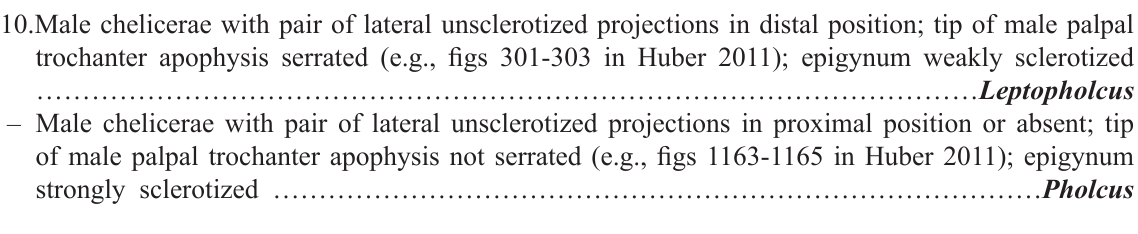
– Abdomen cylindrical or worm-shaped (Figs 2, 4) ………………………………………………10 9. Procursus with long hinged dorsal process, epigynum weakly sclerotized, internal u-shaped structure visible through cuticle frontally (figs 83-89 in Huber 2011) … Micropholcus fauroti (Simon, 1887) – Procursus widely curved, without long dorsal process (figs 204-205 in Huber 2003b); female unknown 10.Male chelicerae with pair of lateral unsclerotized projections in distal position; tip of male palpal trochanter apophysis serrated (e.g., figs 301-303 in Huber 2011); epigynum weakly sclerotized – Male chelicerae with pair of lateral unsclerotized projections in proximal position or absent; tip of male palpal trochanter apophysis not serrated (e.g., figs 1163-1165 in Huber 2011); epigynum 11. eyes close together on turret, in male with frontal hairy pocket; male chelicerae with pair of small frontal apophyses, without proximal lateral projections (figs 2-4 in Huber 1996) – eyes not on turret; male chelicerae with proximal lateral projections ……………………………12 12. Sternum with unique pattern of dark lines radiating from behind labium; male palpal tibia globular, much larger than femur (figs 8, 33 in Huber 2007) ………………………… Anansus – Sternum pattern different; male palpal tibia not globular, usually not much larger than femur 13. Procursus attachment to tarsus distal rather than proximal; anterior and posterior epigynal sclerite with one pair of pockets each (figs 62-66 in Huber 2007) ………… Spermophorides – Procursus attachment to tarsus rather proximal; posterior epigynal sclerite without pair of pockets …14 14. Prolateral attachment of bulb to tarsus; proximal bulbal sclerite strongly developed (Figs 107, 112); epigynum with pair of external pockets, never with scape …………………………………………15 – Dorsal attachment of bulb to tarsus (e.g., Figs 75, 87, 97); proximal bulbal sclerite absent or poorly developed and hidden; epigynum without pair of pockets, often with scape …………16 15. Male frontal cheliceral apophyses small (Fig. 113), close together; corresponding female pockets (poorly visible in dissecting microscope) also close together …… Quamtana (except Q. kitahurira ) – Male frontal cheliceral apophyses large (Fig. 109), wide apart; corresponding female pockets (poorly visible in dissecting microscope) also wide apart ………… Spermophora kyambura sp. nov. 16. Procursus without ventral flap (e.g. Figs 76, 82) ……………………………………… Buitinga – Procursus with ventral flap (e.g. Figs 88, 93, 98, 103) … Spermophora (except S. kyambura sp. nov.)